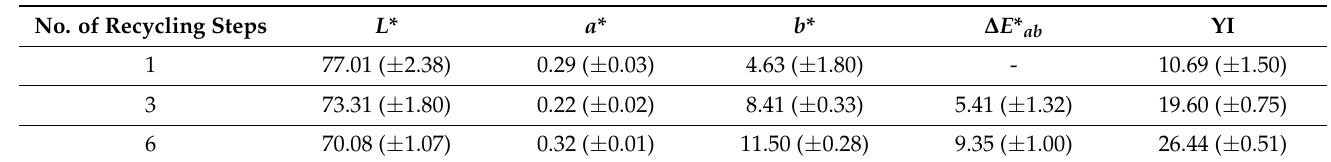
Table 2. Color parameters of injection-molded samples of PLA after being subjected to varying degrees of mechanical